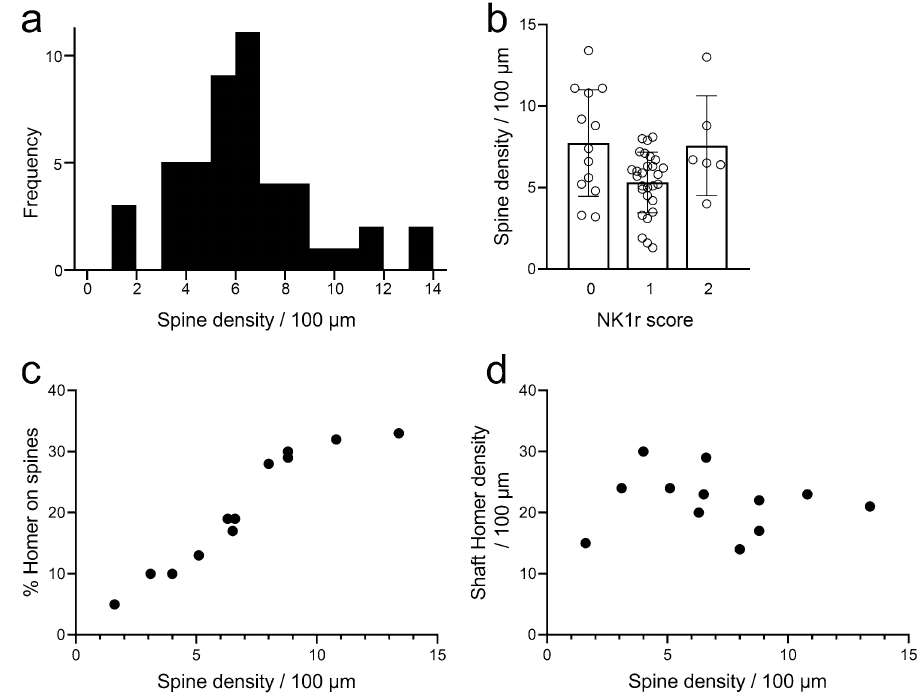
Figure 10. Quantitative analysis of dendritic spines and Homer puncta. ( a ) Frequency histogram showing the range densities on the 47 neurons analysed from the 3 Phox2a::Cre;Rosa26 LSL ChR2-EYFP mice. ( b ) Spine densities for cells classified as strongly NK1r-immunoreactive (2), weakly immunoreactive (1) or non-immunoreactive (0). There was no significant difference between the three classes. Mean and SD are indicated. ( c ) There was a strong correlation between the dendritic spine density and the proportion of Homer puncta that were located on spines for the 12 cells in which Homer was analysed. ( d ) There was no correlation between spine density and the density of Homer puncta that were located on dendritic shafts for these